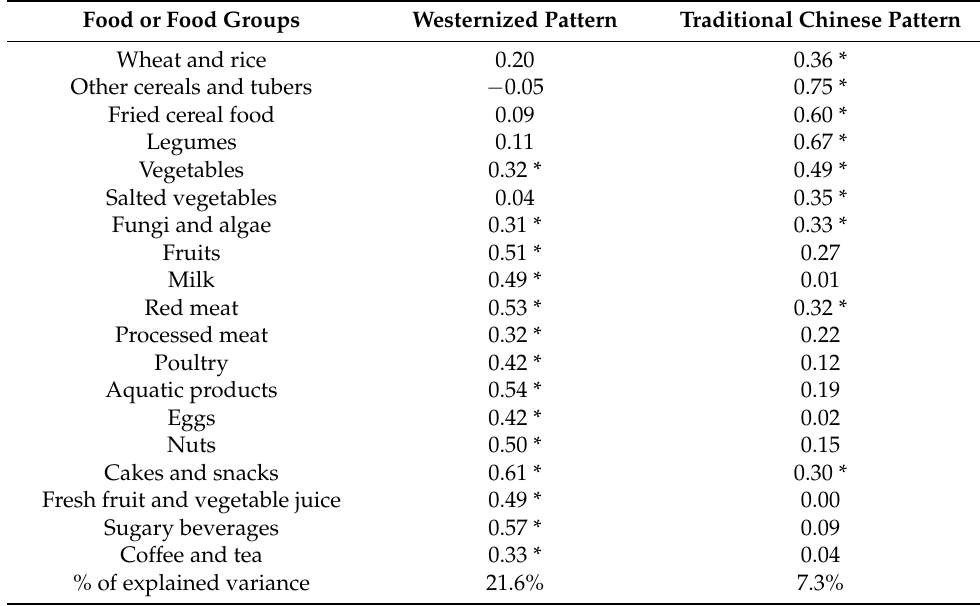
Table 2. Factor-loading matrix for the two dietary patterns and their food or food groups in Chinese children.